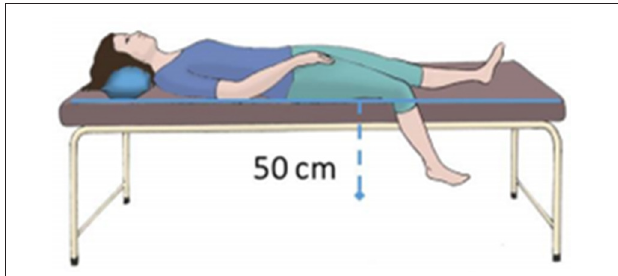
FIGURE 1 | Illustrative scheme of the posture adopted by the subject during the challenge phase of the protocol.